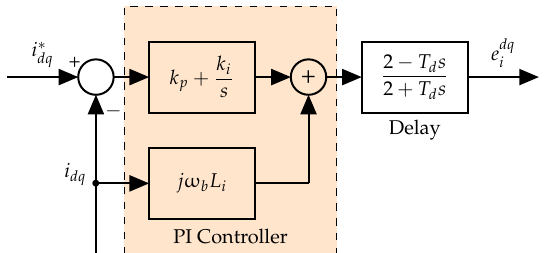
Figure 6. Block diagram of the PI regulator and equivalent delay (PI + delay) of the digital control and